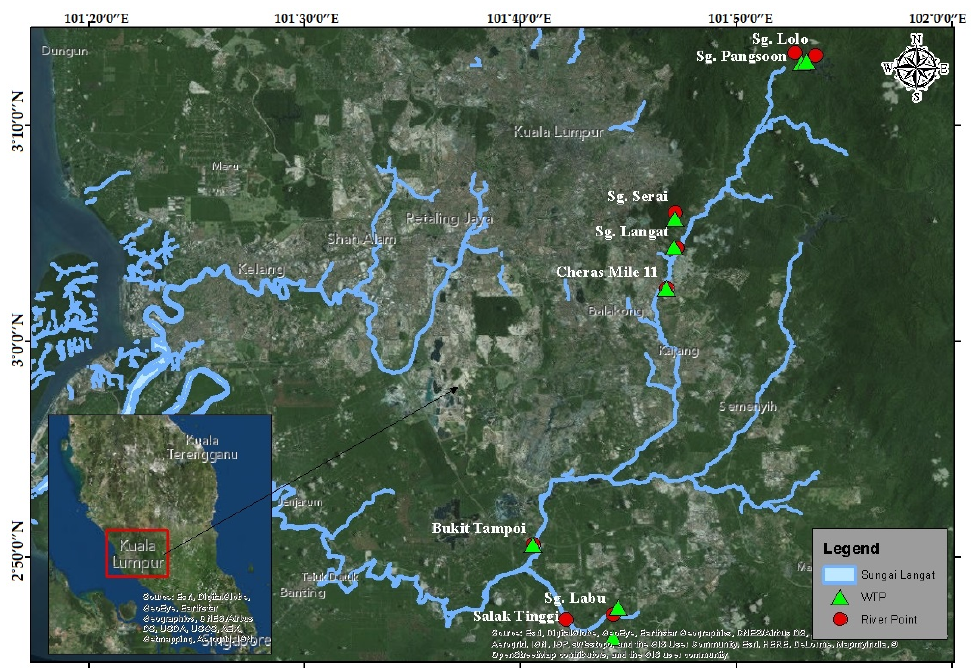
Figure 1. Water sampling points, (i.e., river points) at the Langat River Basin, Malaysia.